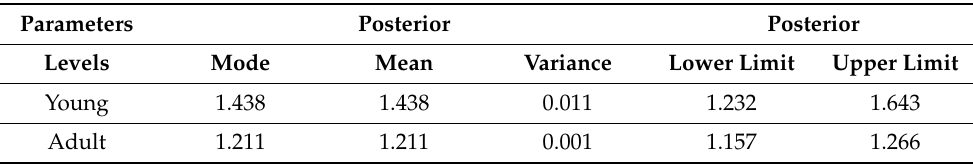
Table 5. Summary of descriptive statistics of the posterior distribution for the predator’s age range factor.